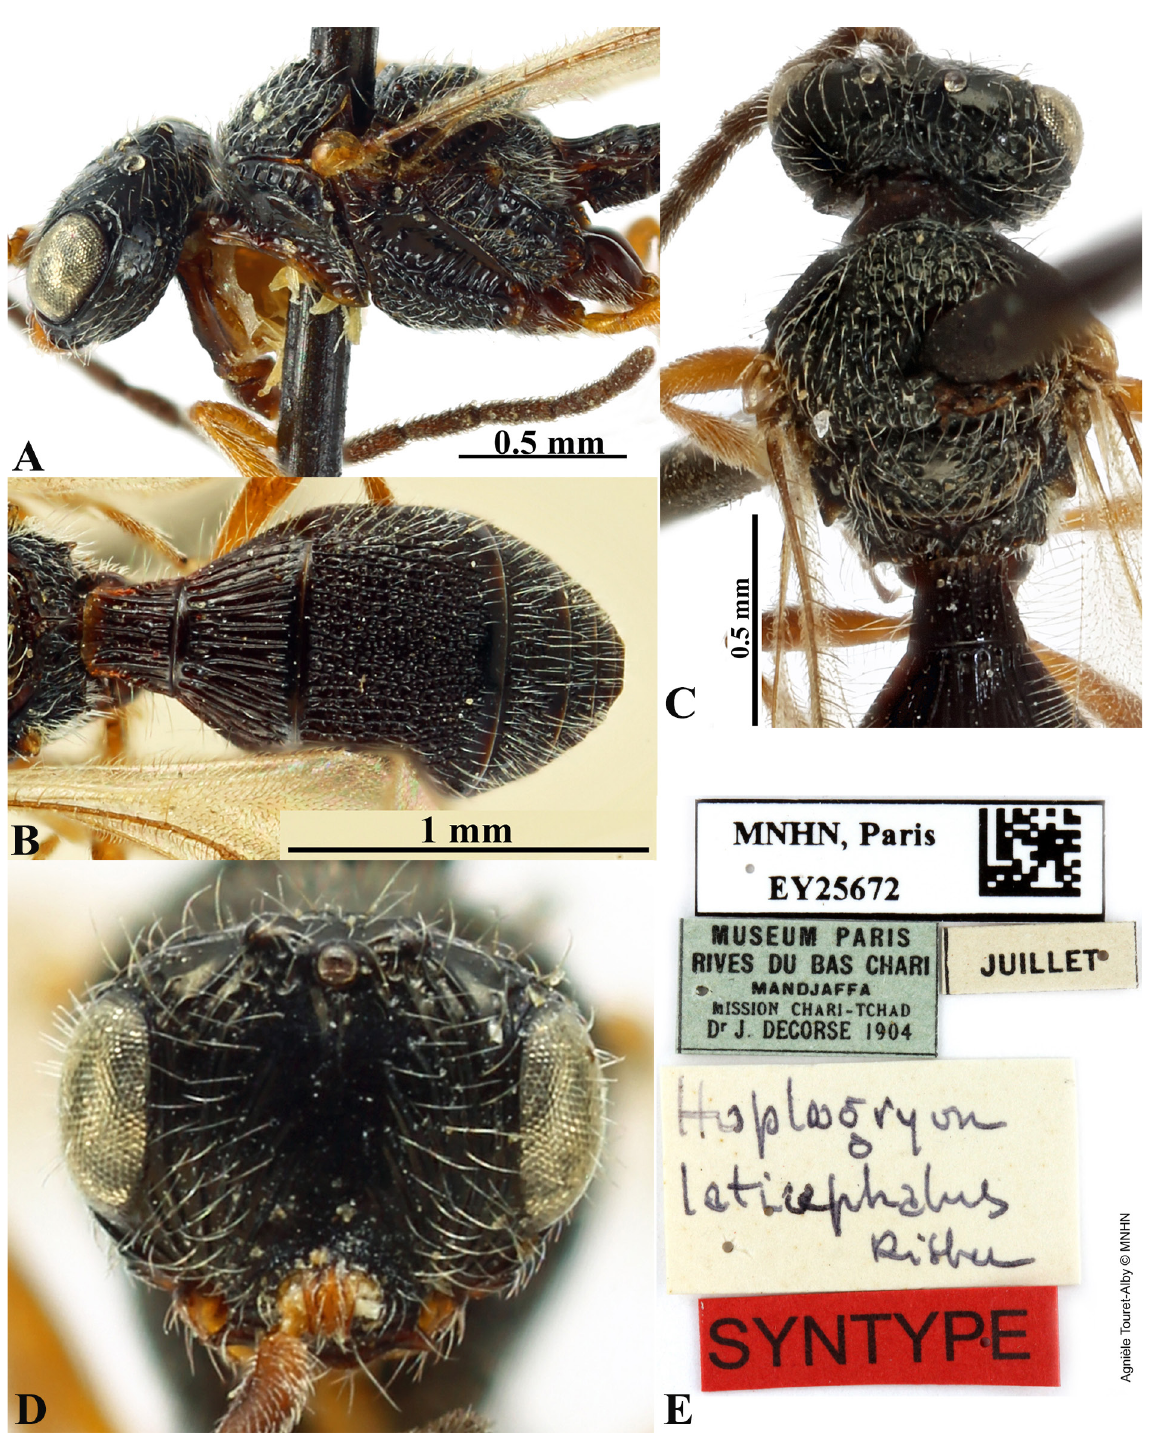
Fig. 14. Odontoscelio laticephalus (Risbec, 1950). Syntypes, ♂♂ (A: MNHN EY25673; B: MNHN EY25672; C–D: MNHN EY25675). A . Head and pleuron. B . Metasoma. C . Head and